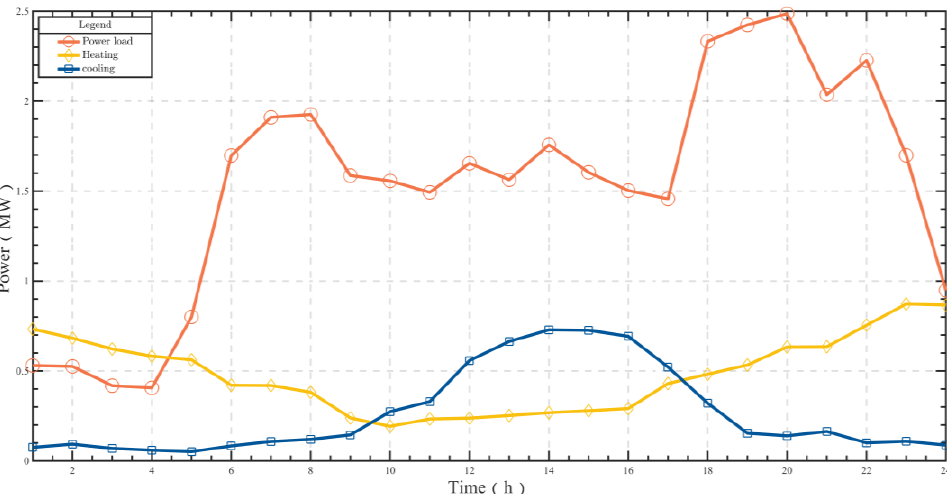
Figure 3. The daily cooling, heating, and power load of the RDES.